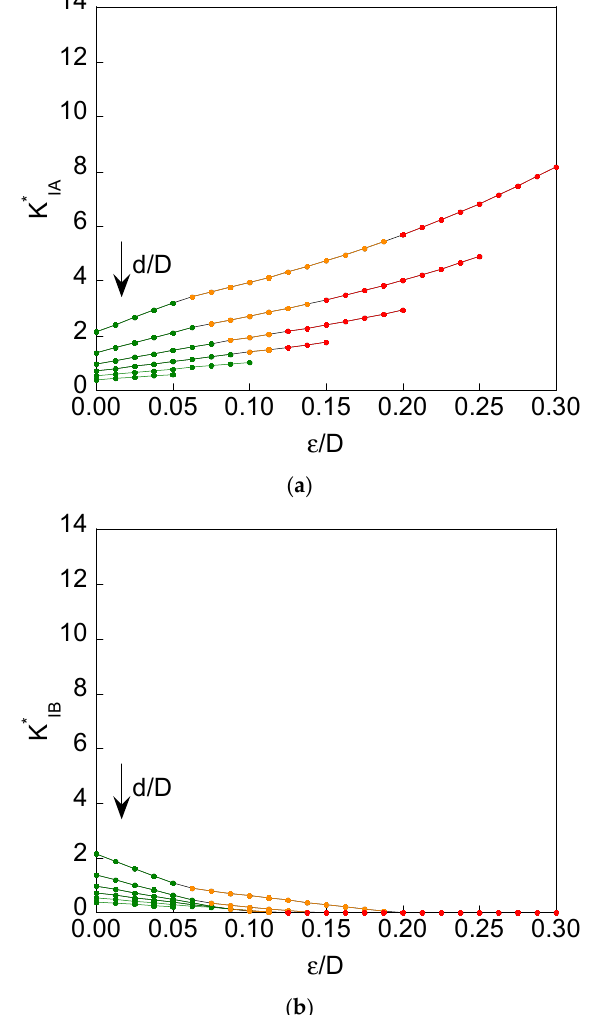
Figure 3. For imposed axial displacement and d / D = {0.3, 0.4, 0.5, 0.6, 0.7 and 0.8}: ( a ) maximum dimensionless SIF K * IA vs. relative ligament eccentricity ε / D; ( b ) minimum dimensionless SIF K * IB vs. relative ligament eccentricity ε / D (green: no contact ; orange: partial contact ; red: full contact ).